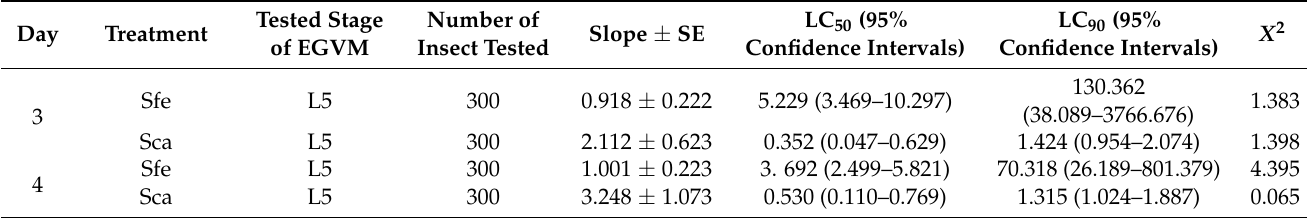
Table 3. Lethal concentration (LC) responses against L5 larval stages of the European grapevine moth (EGVM), Lobesia